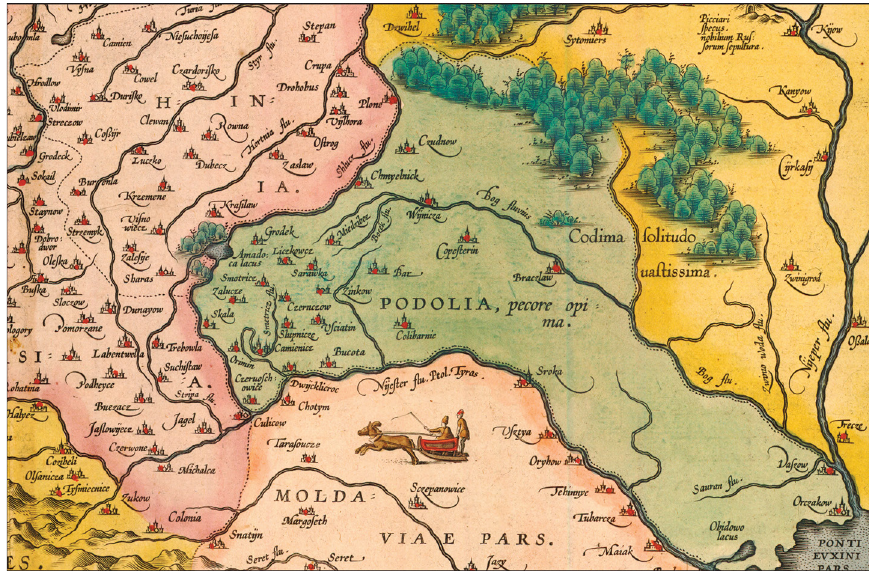
Fig. 2. Part of the map of Poland by A. Pograbka